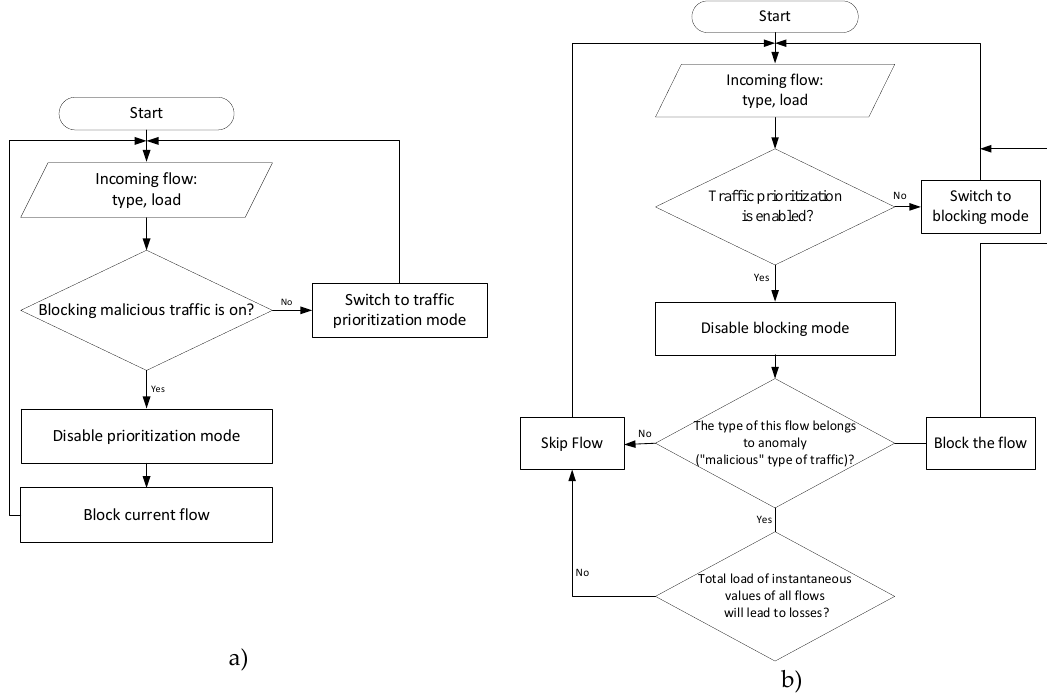
Figure 19. Algorithm of anomaly blocking (a) and traffic prioritization (b) mode.